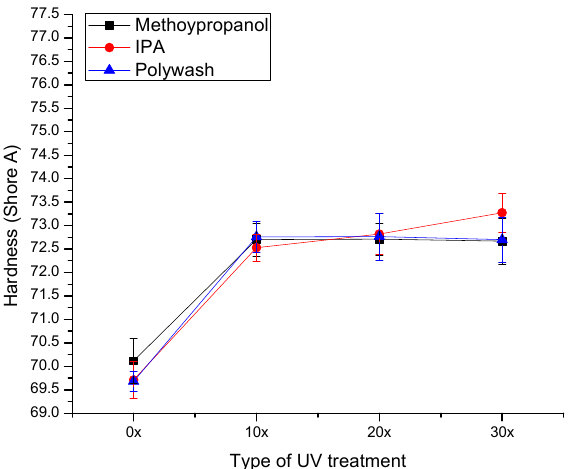
Figure 5. Hardness of the modified EPDM printing plate samples after exposure to solvents.